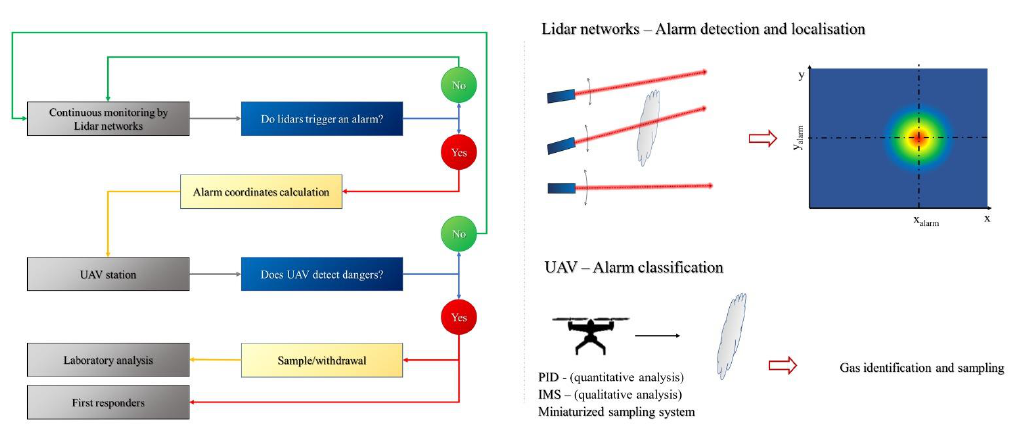
Figure 1. Schematic representation of the overall system and of its operational logic.